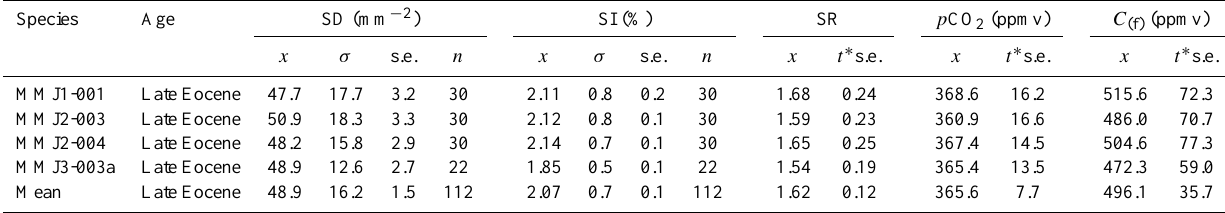
Table 7. Summary of stomatal parameters of the abaxial surface of fossil Nageia and p CO 2 [ C (f) ] estimates results. Species